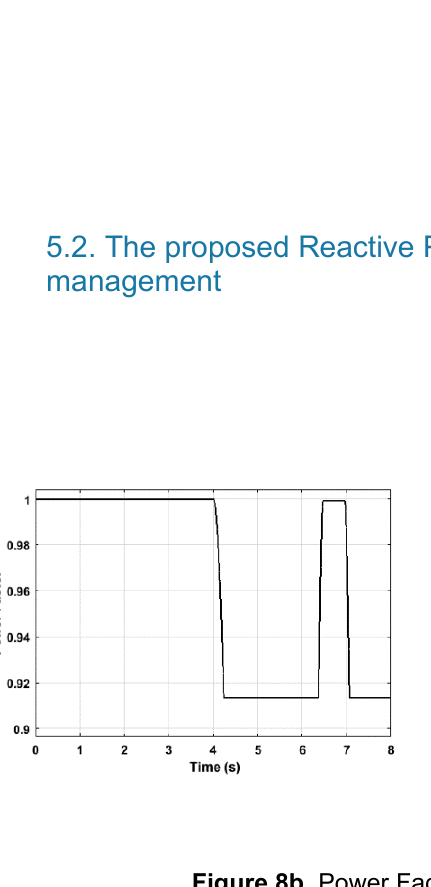
Figure 8a. Wind Speed Figure 8b. Power Factor